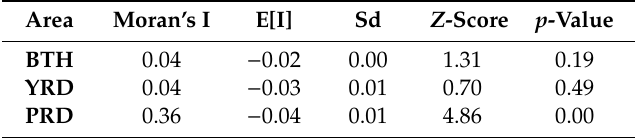
Table 2. Moran’s I of IFMA i in the di ff erent urban agglomerations.